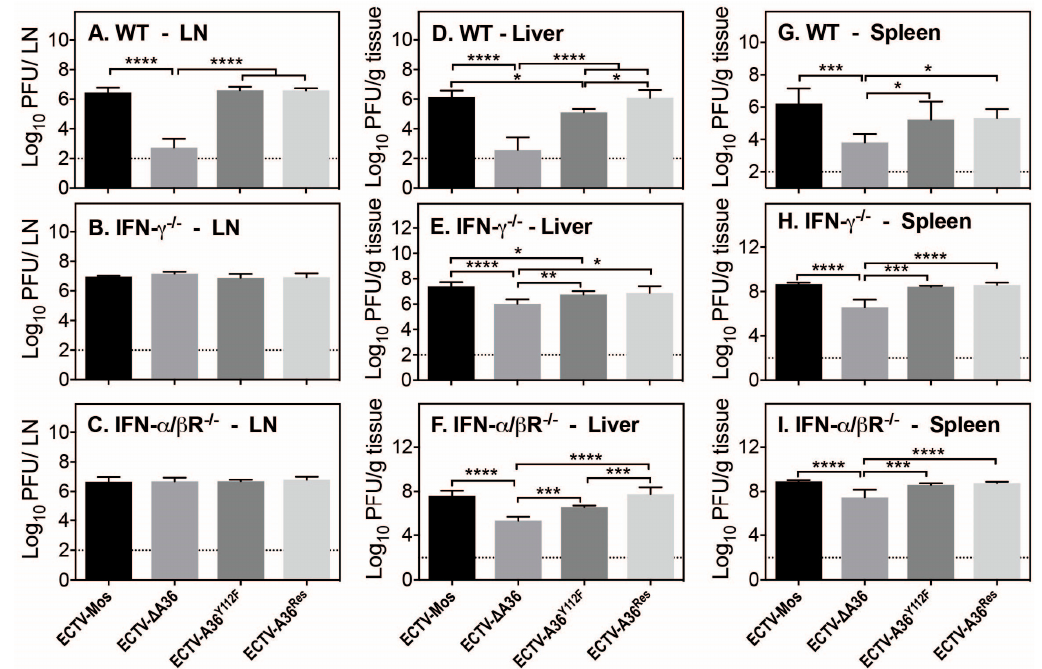
Figure 5. Loss of microtubule transport and actin-based motility results in attenuation in vivo. C57BL/6 mice with WT, IFN- γ − / − or IFN- α / β R − / − genetic backgrounds were infected subcutaneously in the right hind paw with 10 3 PFU virus and sacrificed at five days pi, viral dissemination to ( A – C ) the popliteal lymph nodes; ( D – F ) the liver and ( G – I ) the spleen, was quantified by plaque assay. (**** p < 0.0001; *** p < 0.001; ** p < 0.01; * p < 0.05; one-way ANOVA).